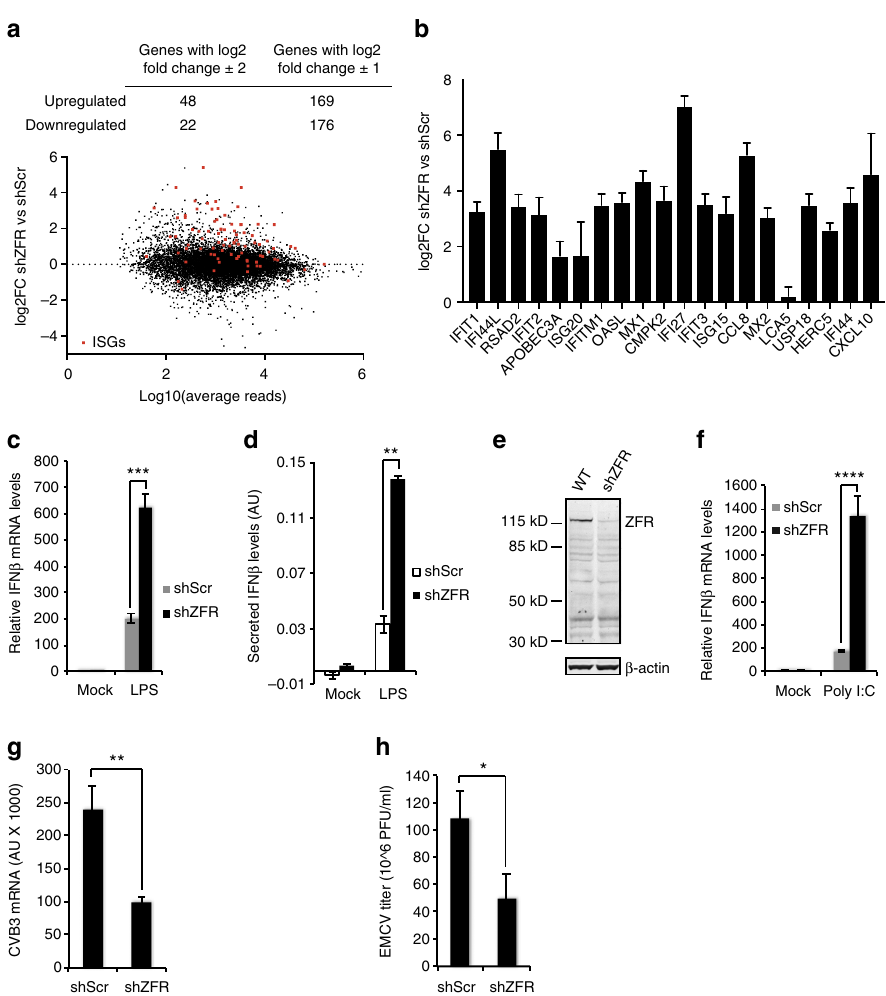
Fig. 5 ZFR suppresses IFN β induction and the antiviral response. a RNA-seq analysis of differentiated THP-1 cells stably transduced with shZFR or shScr ( n = 3). Top, numbers of genes upregulated or downregulated by ZFR depletion at the indicated thresholds. Bottom, scatter plot of fold change in mRNA abundance vs. number of reads derived from each gene, with mRNAs from previously identi fi ed ISGs shown in red 61,62 . b Induction of a previously characterized panel of ISGs 63 in differentiated THP-1 cells depleted of ZFR. Mean log2 fold change and SD from three RNA-seq replicates are shown. c qRT-PCR analysis of IFNB1 in differentiated THP-1 cells stably transduced with shZFR or shScr and treated with LPS ( n = 3). d ELISA assay of secreted IFN β in differentiated THP-1 cells stably transduced with shZFR or shScr and treated with LPS. e Immunoblot analysis of ZFR in HEK-293TO cells stably transduced with shZFR or shScr. β -Actin was used as a loading control. Approximate MW based on size markers is shown. f qRT-PCR analysis of IFNB1 after poly(I:C) induction in HEK-293TO cells stably transduced with shZFR or shScr ( n = 4). g qRT-PCR analysis of Coxsackievirus B3 (CVB3) in the indicated HEK-293TO cells 6 h after infection ( n = 3). h Virus titer measured by plaque assay 48 h after EMCV infection in the indicated HEK-293TO cells ( n = 3). Graphs indicate mean ± SD; ** P < 0.01, **** P < 0.0001 (two-tailed Student ’ s t